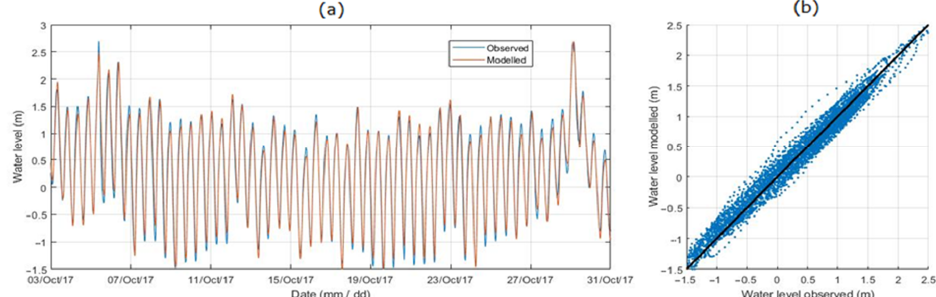
Figure C1. Comparison of observed and modeled water levels at measurement station ‘Lauwersoog’ ( a ) over time and ( b ) in a scatter plot with identity line (black solid line).